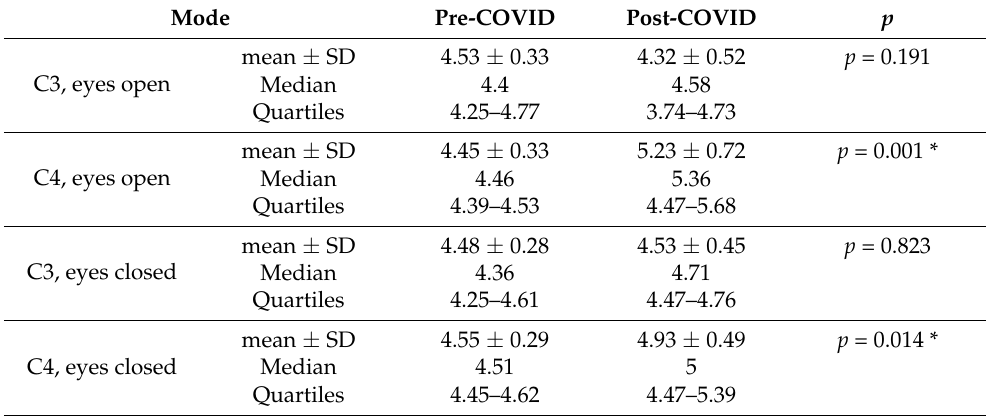
Table 5. The results of the Beta 1 waves examination (waves from C3, C4 channels).